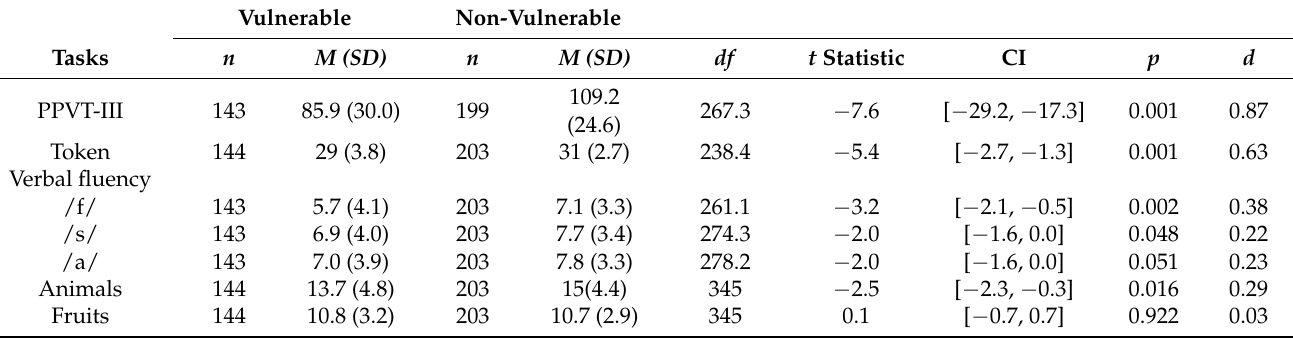
Table 3. Language tests raw scores and independent samples t -test results. Vulnerable